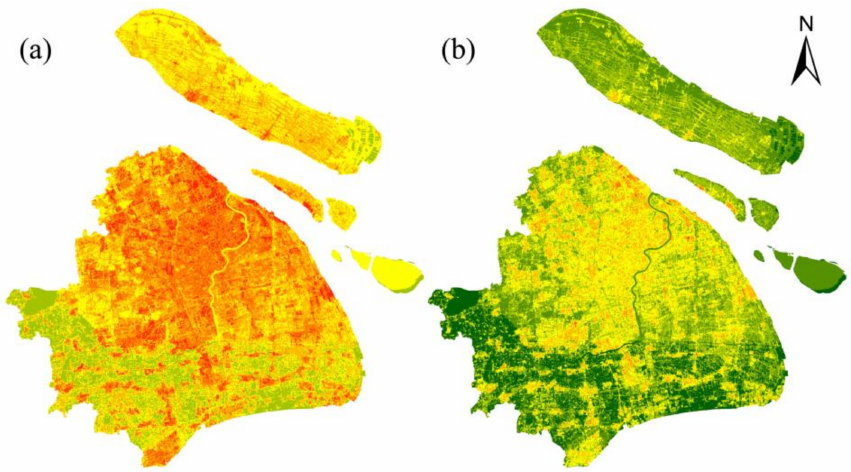
Figure 2. Comparison of the retrieval results of four algorithms on 21 January 2020. ( a – d ) are RTE, MWA, SWA, and SCA retrieval results,